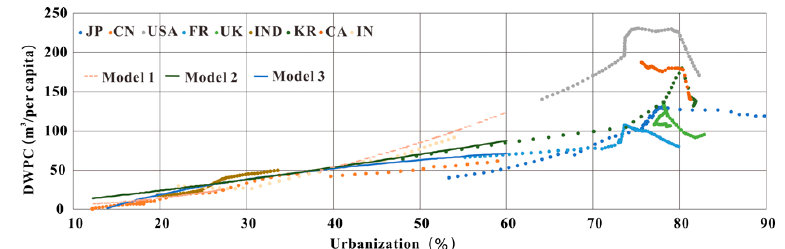
Figure 2. Relationship between urbanization and DWPC.